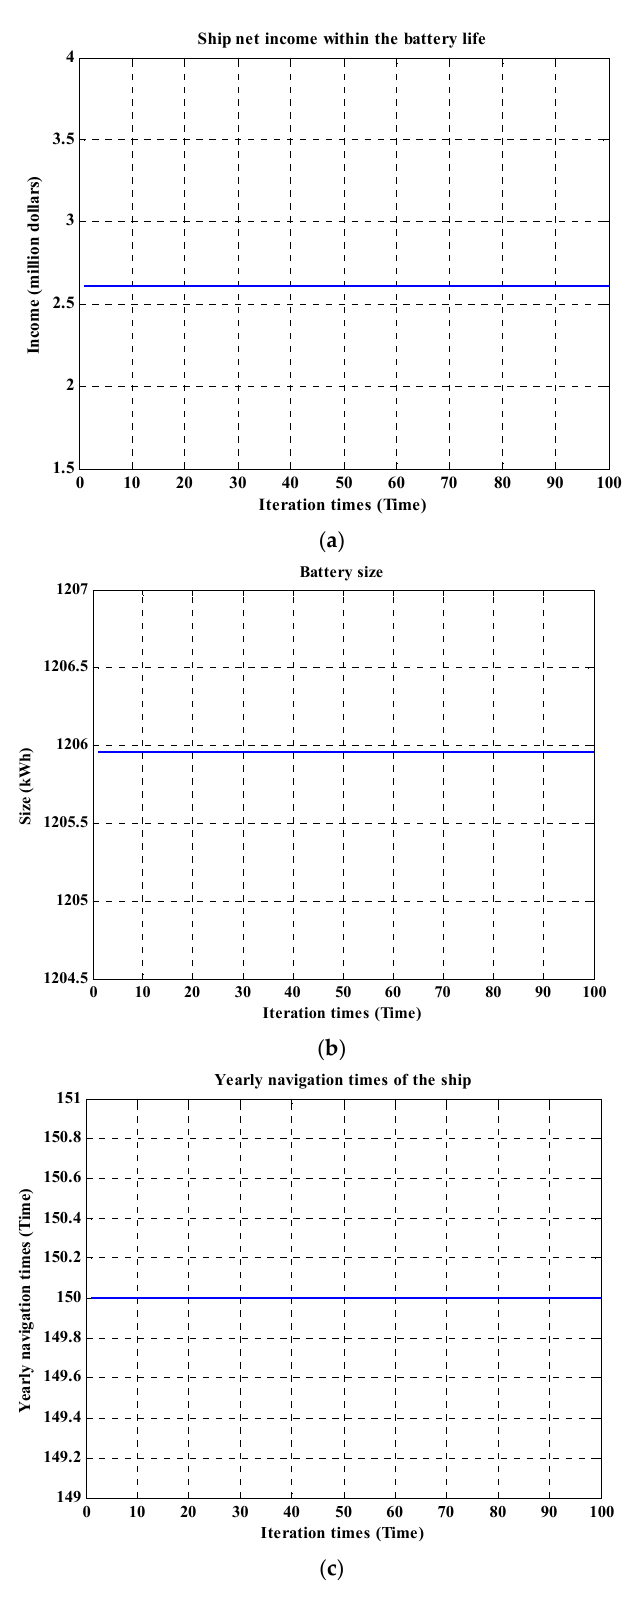
Figure 10. Simulation results of scenario 1 in case 2. ( a ) Variation of ship net income within the battery life over the optimization procedure. ( b ) Battery capacity variation over the optimization procedure. ( c ) variation of yearly navigations over the optimization